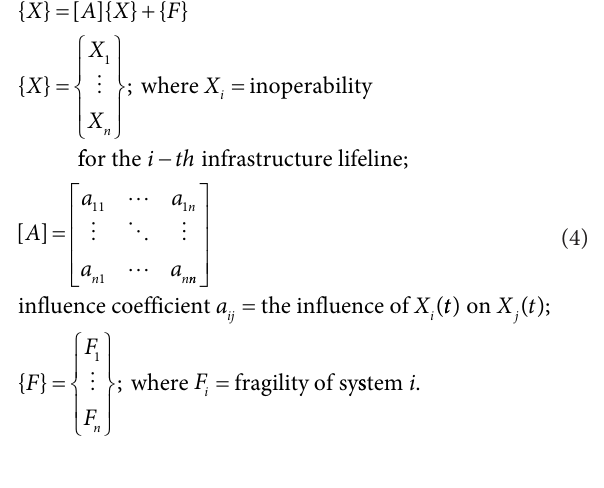
TaBle 2 | Single degree of freedom system fits for X(t) data corresponding to the hurricanes described in Table 1 . hurricane